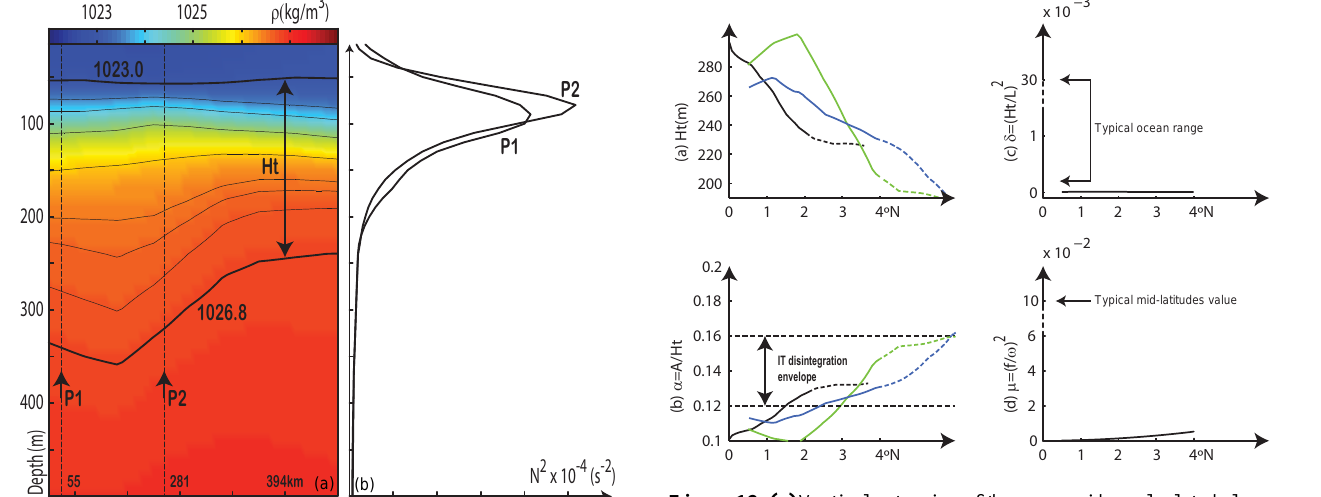
Figure 12. (a) Vertical extension of the waveguides calculated along the waves’ propagation paths (in green, blue and black, according to dashed propagation paths in Fig. 9). (b) Same as panel (a) but for the non-linear parameter computed assuming an IT amplitude of 30m. (c) Nonhydrostatic dispersion for L = 100km. (d) Rotational dispersion for the semi-diurnal IT. Transitions to dashed lines in left panels indicate first SAR evidence of ISWs. Note broken vertical axes in right panels and typical ocean values showing comparatively weak dispersions in our study region. See text for more